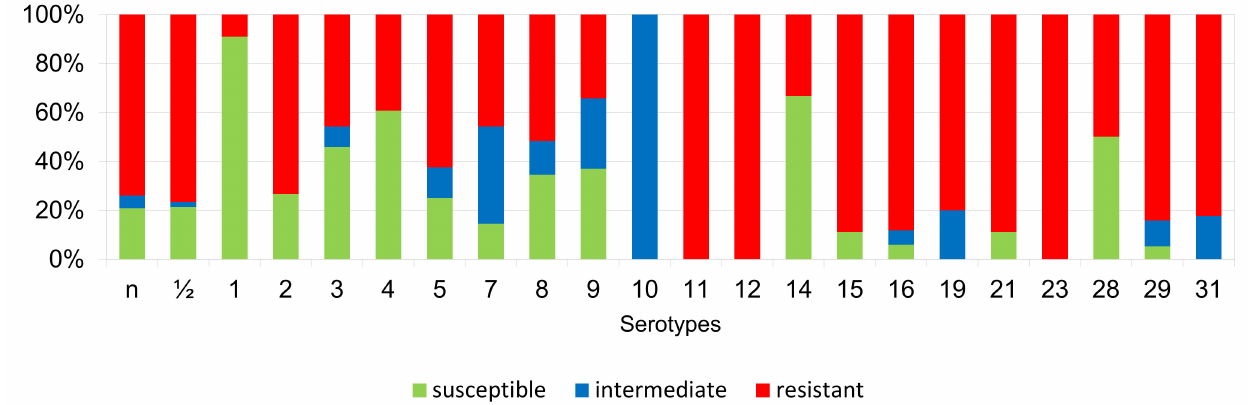
Figure 13. Percentage representation of isolates resistant, intermediately resistant, and susceptible to tetracycline belonging to individual S. suis serotypes from the Czech Republic during 2018–2022 ( n =